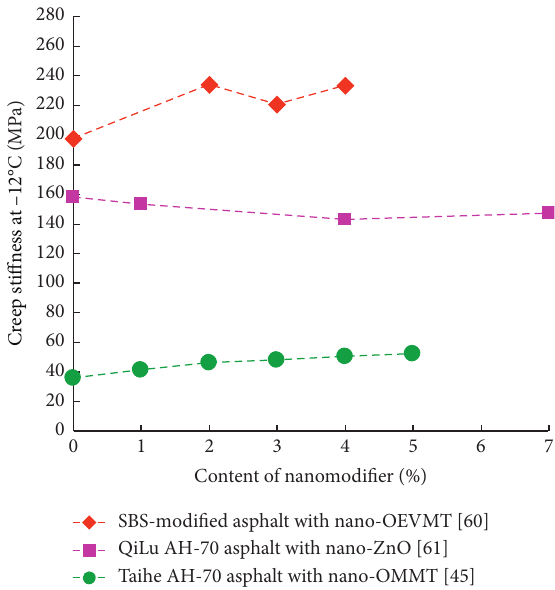
Figure 12: Creep stiffness and nanomodifier